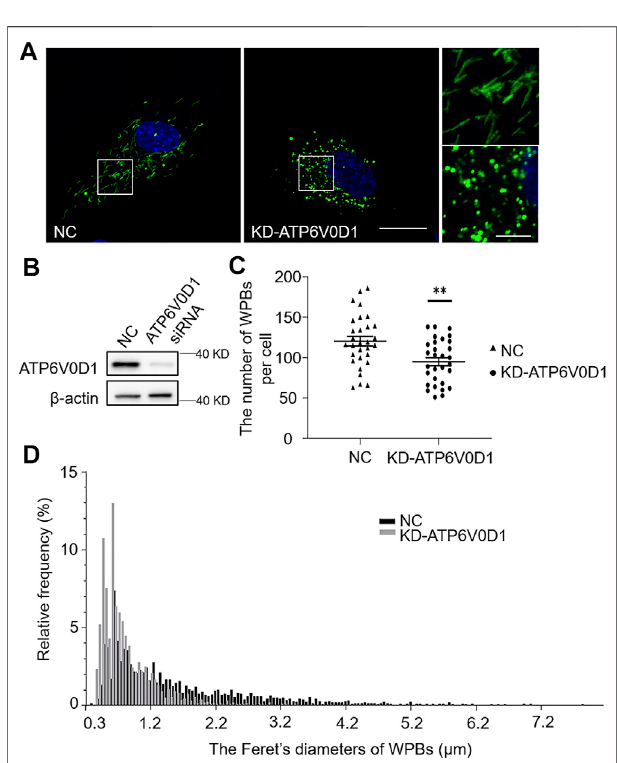
FIGURE 6 | Knockdown of ATP6V0D1 in human umbilical vein endothelial cells (HUVECs) phenocopies the abnormalities of Weibel – Palade bodies (WPBs) KD-HPS6 HUVECs. ( A ) Immuno fl uorescence images of negative control (NC) and ATP6V0D1 siRNA (KD-ATP6V0D1)-mediated knockdown in HUVECs labeled against vWF (green) and nucleus (DAPI, blue). Scalebar,20 μ m.Theboxedsquaresweremagni fi ed,respectively.Scalebar, 5 μ m. ( B ) Western blotting analysis of the detection of ATP6V0D1 knockdown. ( C ) Quantitative analysis of the number of WPBs per cell of NC and KD-ATP6V0D1 HUVECs ( n = 30, ** p < 0.01). ( D ) Feret ’ s diameter distribution of WPBs at each group of HUVECs was analyzed quantitatively (NC: 3,608 WPBs, black; KD-ATP6V0D1: 2,852 WPBs, gray). Data were expressed asmean ± SEM. Three independent experiments were performed.